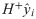
Experimental data (a-b) and fitting results (c-d) for animal RQ3570.The values of his are set to be equal to H+y^i. Other parameters are taken from Tables 1 and 2. The LSE fitting results are Le*=24.0 and (Ass+)*=19.3.